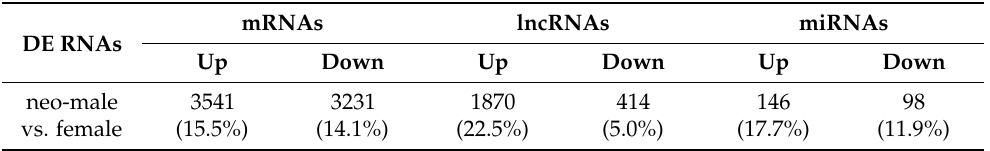
Figure 2. Differential expression of mRNAs ( a , d ), lncRNAs ( b , e ) and miRNAs ( c , f ) in gynogenetic P. olivaceus gonads. Red spots indicate up-regulation in testes, and blue spots represent down-regulation in testes. Table 1. Differentially expressed coding and non-coding RNAs in gynogenetic P. olivaceus gonads. Percentage in parenthesis represents the proportion of regulated RNAs to their total